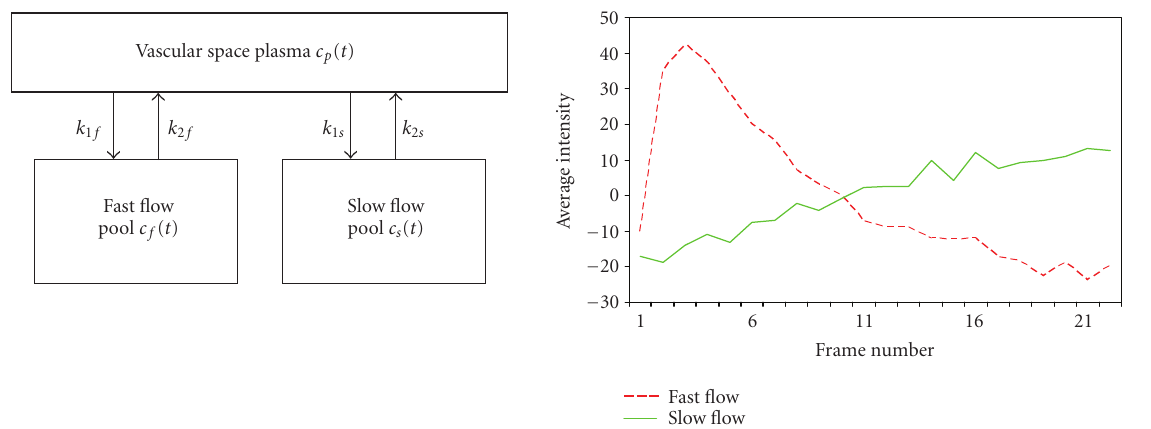
Figure 1: Schematic diagram of two-tissue compartment model and time-activity curves of fast and slow di ff usions for quantifying tumor vascular characteristics based on DCE-MRI. The patterns of interest include the heterogeneous spatial distribution of vascular permeability associated with fast and slow di ff usions.